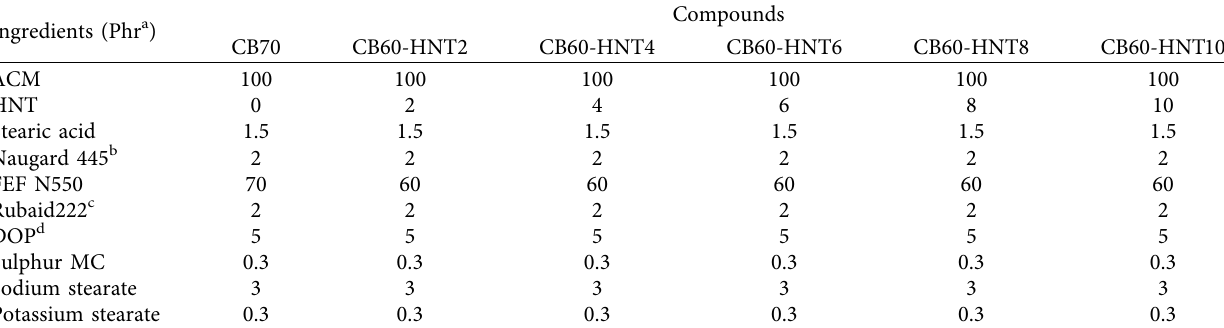
Table 1: ACM hybrid nanocomposites formulation table.